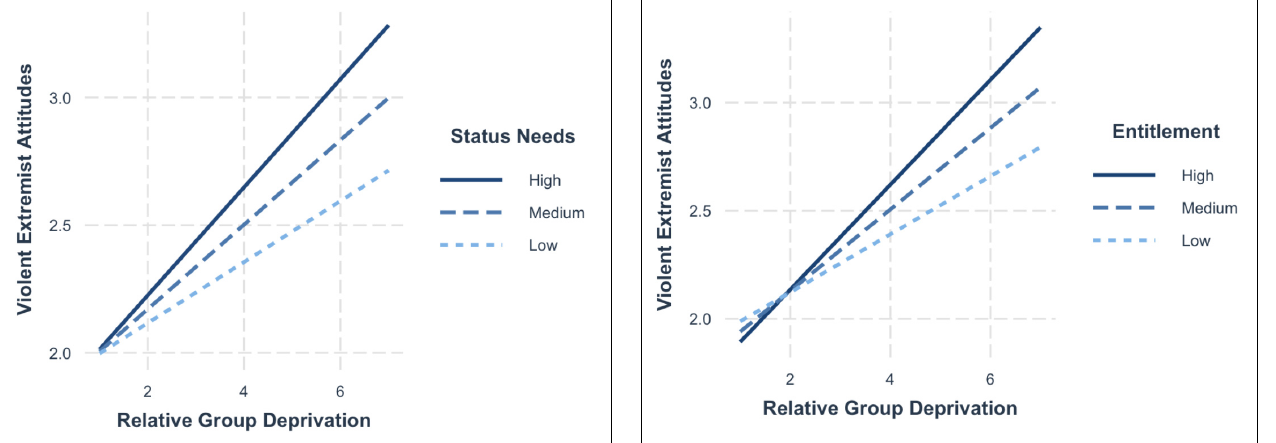
extremist violence for individuals who experience relative group